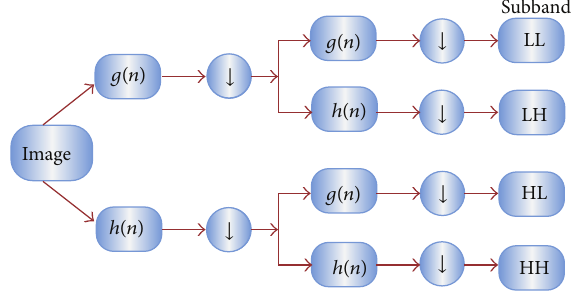
Figure 3: Schematic diagram of 2D DWT.